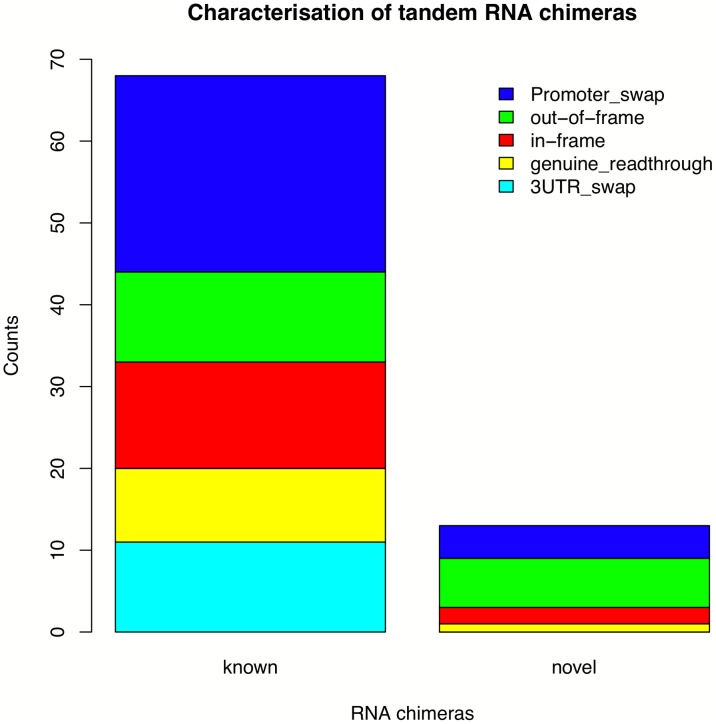
Characterization of tandem RNA chimeras.Barplot representing the frequency of the predicted structural classes for all tandem RNA chimeras. The most prevalent observed class is a promoter swap event.